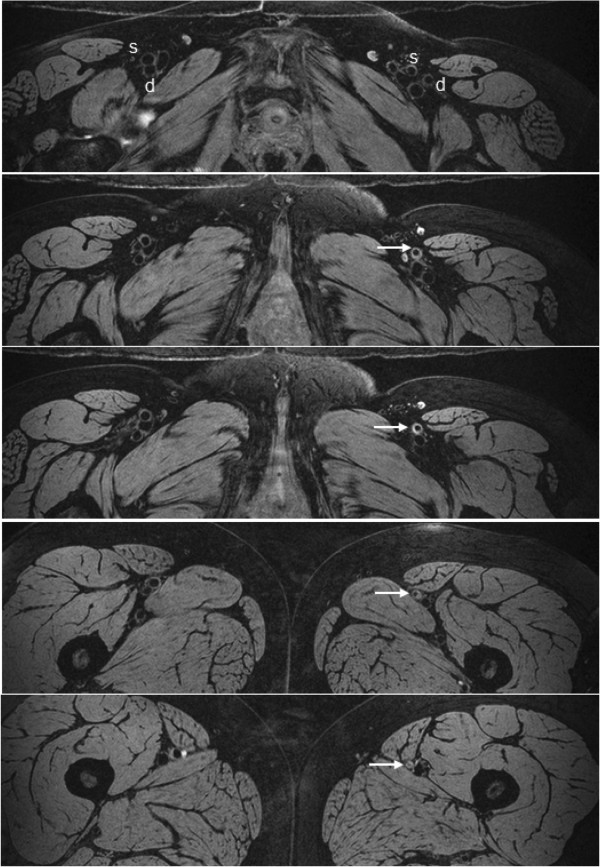
Bilateral images of femoral arteries in a patient with unilateral PAD (ABI = 0.65 left leg, in comparison to disease-free right leg, ABI = 0.95). Simultaneous acquisition of healthy and diseased arteries demonstrates the proposed method’s potential to visualize plaque.